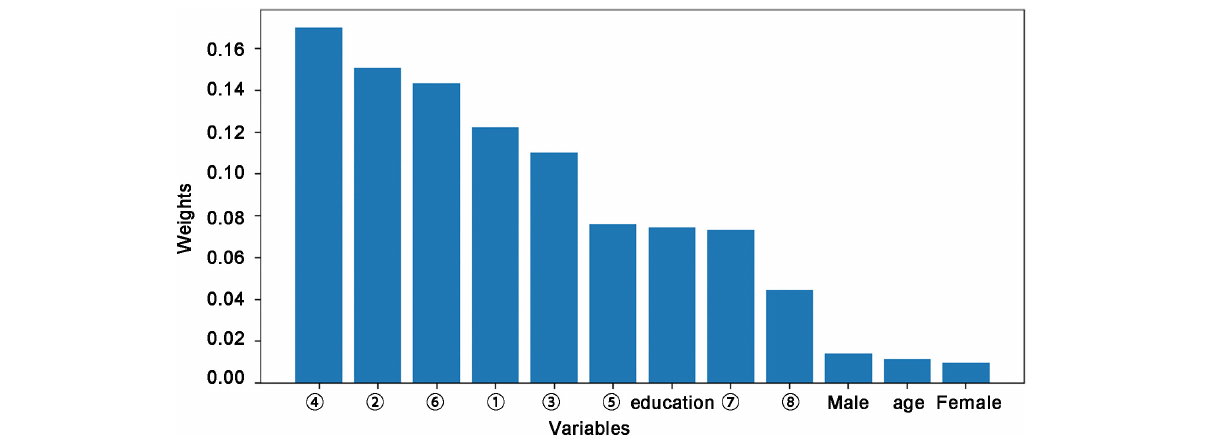
cluster-based FDR (uncorrected voxel P < 0.001 and corrected